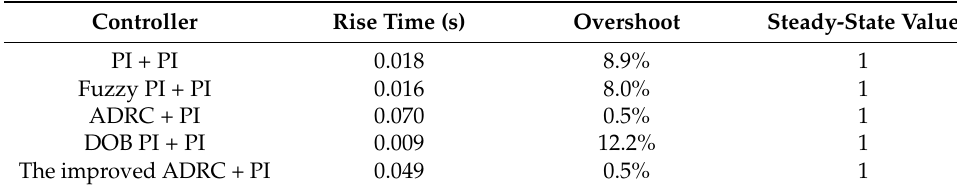
Figure 9. The step response of five controllers. Table 3. The step response